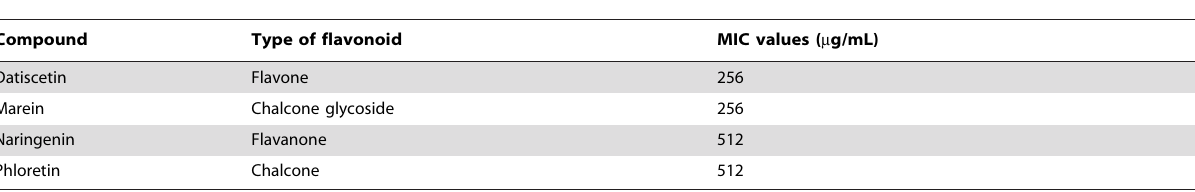
Table 4. List of flavonoids inhibiting Enterococcus faecalis .